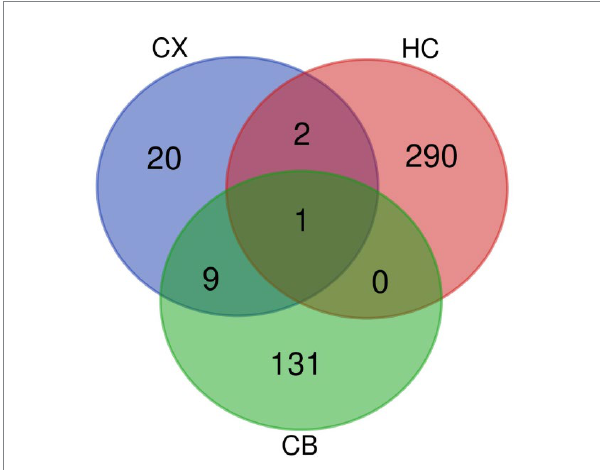
FIGURE 5 Venn diagram of DEGs. The intersections represent the co-DEGs between each brain region. CX, cerebral cortex; HC, hippocampus; CB,